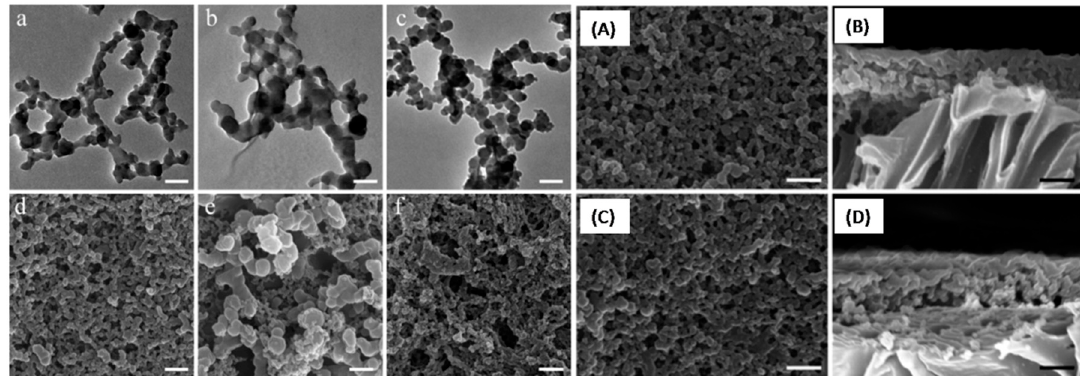
Figure 11. TEM and SEM images of the PVC-NFs made in ( a , d ) DMAC, ( b , e ) NMP, and ( c , f ) DEC solvent and SEM images of PVC mesoporous membranes: top and cross-setion view of the membrane made from ( A , B ) 12 mL and ( C , D ) 14 mL of the nanofiber dispersion, respectively.